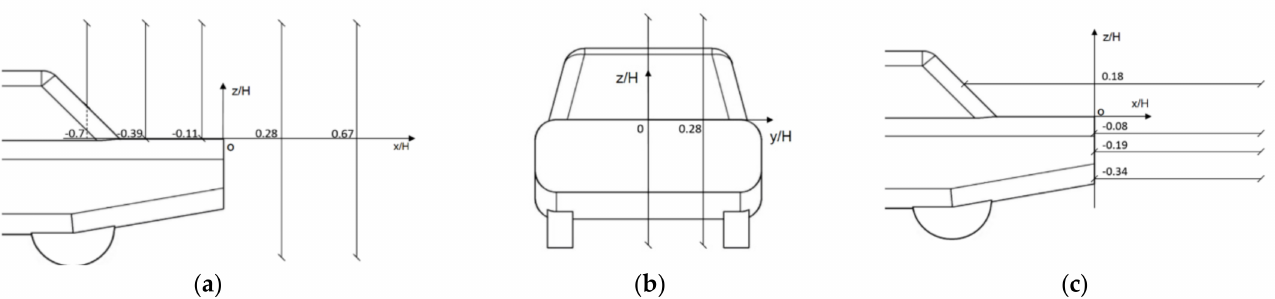
Figure 3. Different plane locations in three orthogonal planes: ( a ) Longitudinal planes; ( b ) Spanwise planes; and ( c ) Trans- verse